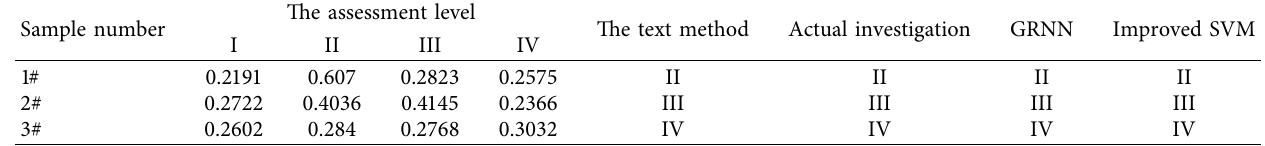
Table 4: Intensity assessment of rockburst and